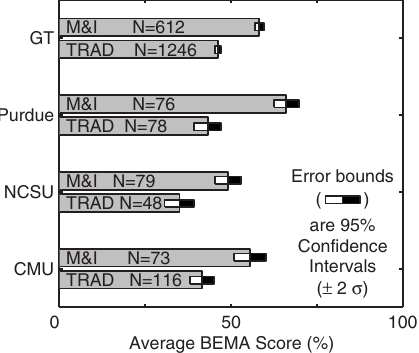
FIG. 1. Average postinstruction BEMA scores at four academic institutions—the average BEMA test scores are shown for students who have completed a one-semester E&M course with either the traditional (cid:1) TRAD (cid:2) or M&I curriculum. The number of students tested for each curriculum at each institution is indicated in the figure. The error bounds represent the 95% confidence intervals on the estimate of the average score.